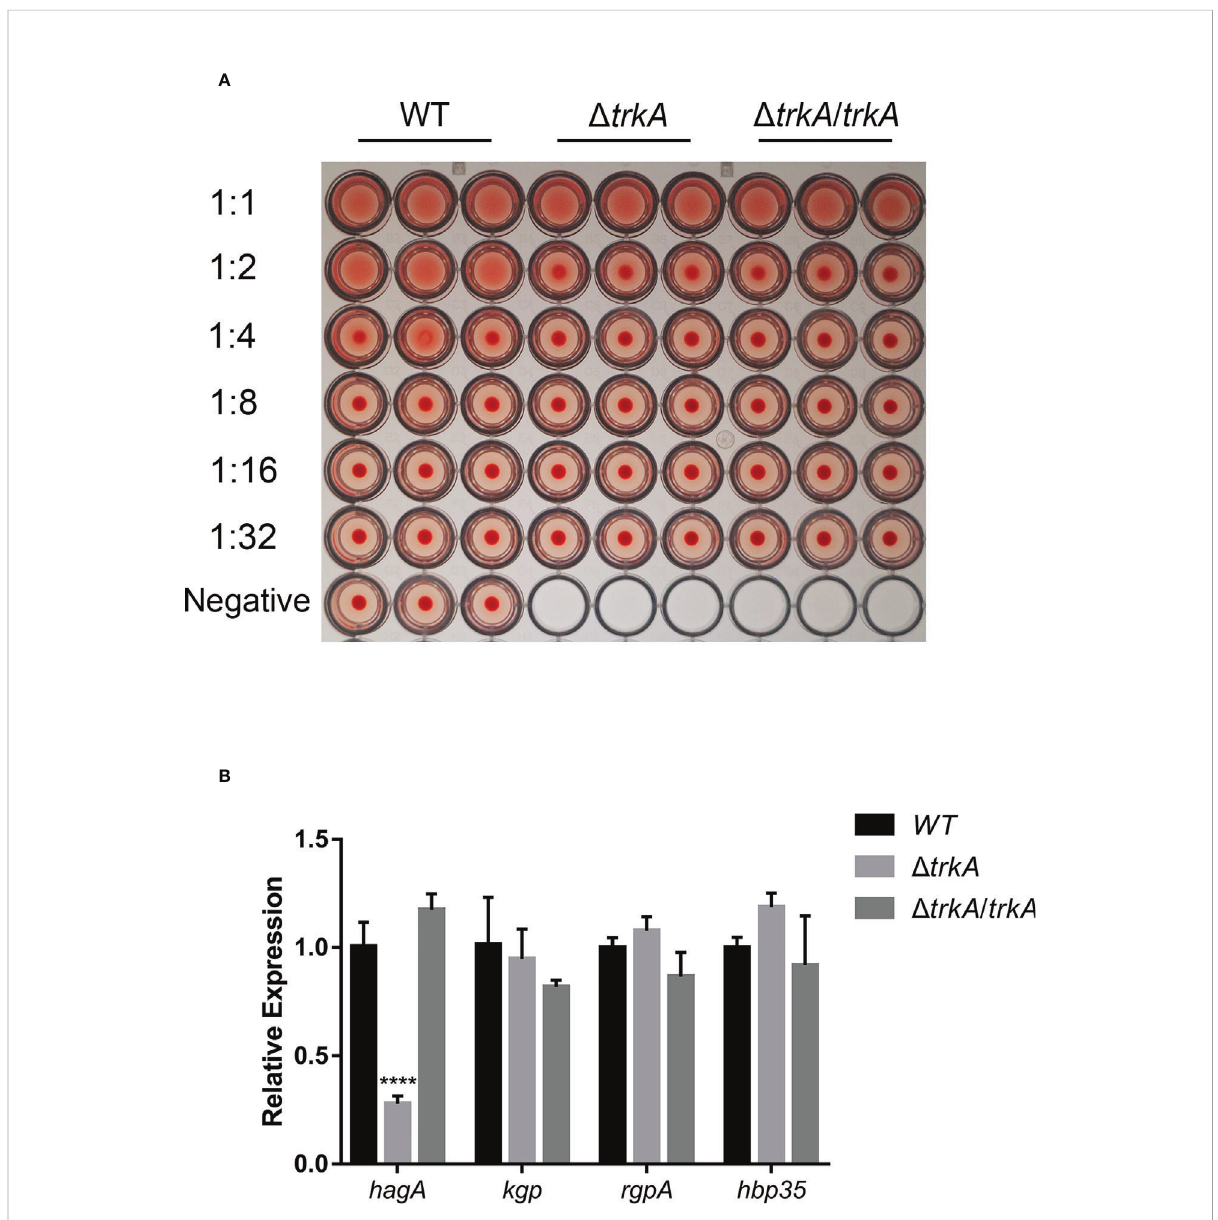
FIGURE 2 trkA deletion attenuates hemagglutination activity of Porphyromonas gingivalis . (A) Hemagglutination activity of P. gingivalis WT, D trkA , and D trkA / trkA strains. (B) qRT-PCR analysis of hagA , kgp , rgpA , and hbp35 mRNA expression in P. gingivalis WT, D trkA , and D trkA / trkA strains. Data are presented as means ± SD, normalized to 16S rRNA and compared to WT (2 − DD CT ). N = 3, **** p <